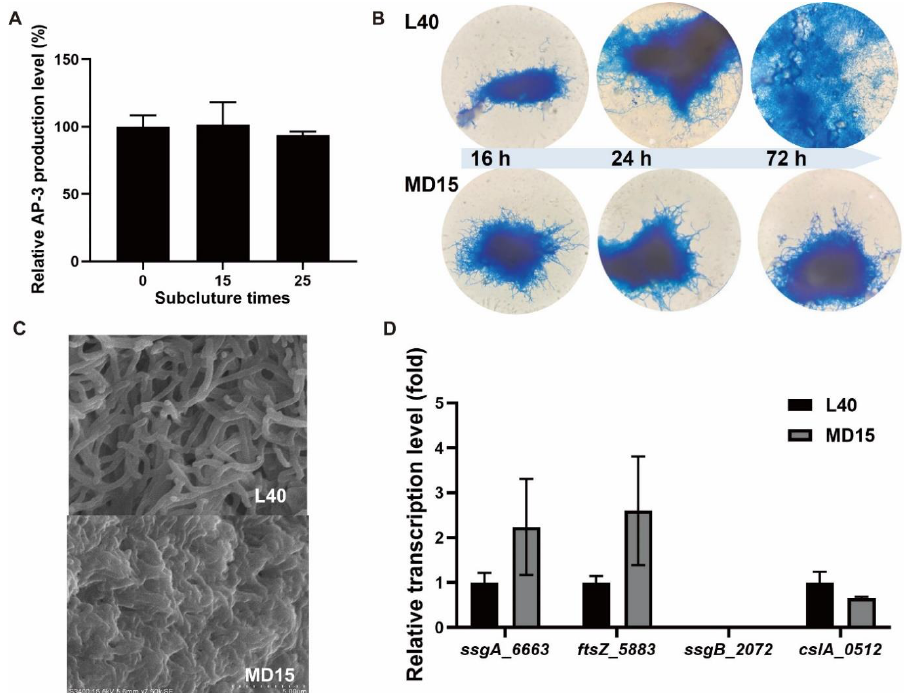
Figure 1. Fermentation stability and morphological variation of mutant MD15. ( A ) Fermentation stability of strain MD15. The strains from original, fifteenth and twenty-fifth subculture were col- lected to perform liquid fermentation. Fermentation experiments were carried out in three biological replicates. The average AP-3 production of the original MD15 strain was set to 100% as the standard, and the values are means ± SD (standard deviations) of three independent experiments. ( B ) Myce- lium morphology changes of strain L40 and mutant MD15 during fermentation. Magnification, 100×. ( C ) Scanning electron micrographs of strain L40 and mutant MD15 on day 3 of YMG solid culture. Scale bar: 5 μ m, Magnification, 7500×. ( D ) Transcription levels of the cell division genes of mutant MD15 on the third day of fermentation. The average expression value of genes in the control strain L40 was set to 1 as the standard, and the values are means ± SD of triplicate analyses. Gene expression level was determined by 2 - ΔΔC t method.